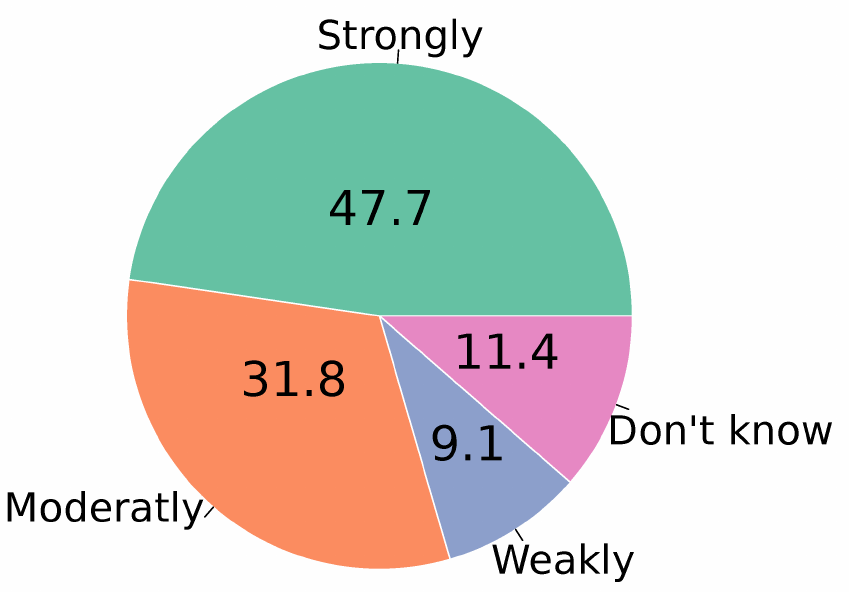
Figure 4. Responses of the question (in % of answers), on ’To what extent do you think eStation information supports decision-making at highest level?’. Only one possible